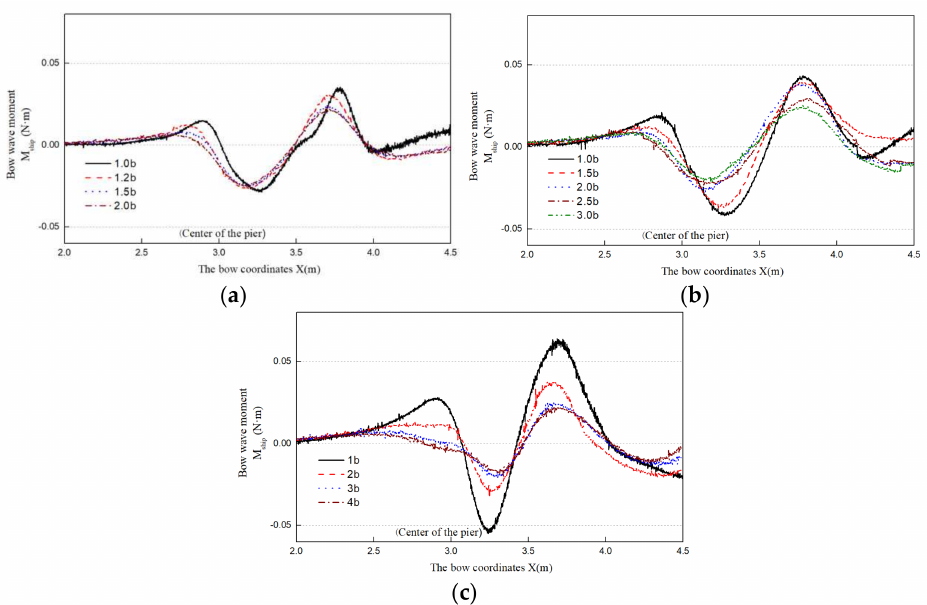
Figure 33. Variation in the bow roll moment of a round-ended pier under different bridge spacings: ( a ) α = 15 ◦ ; ( b ) α = 30 ◦ ; ( c ) α = 45 ◦